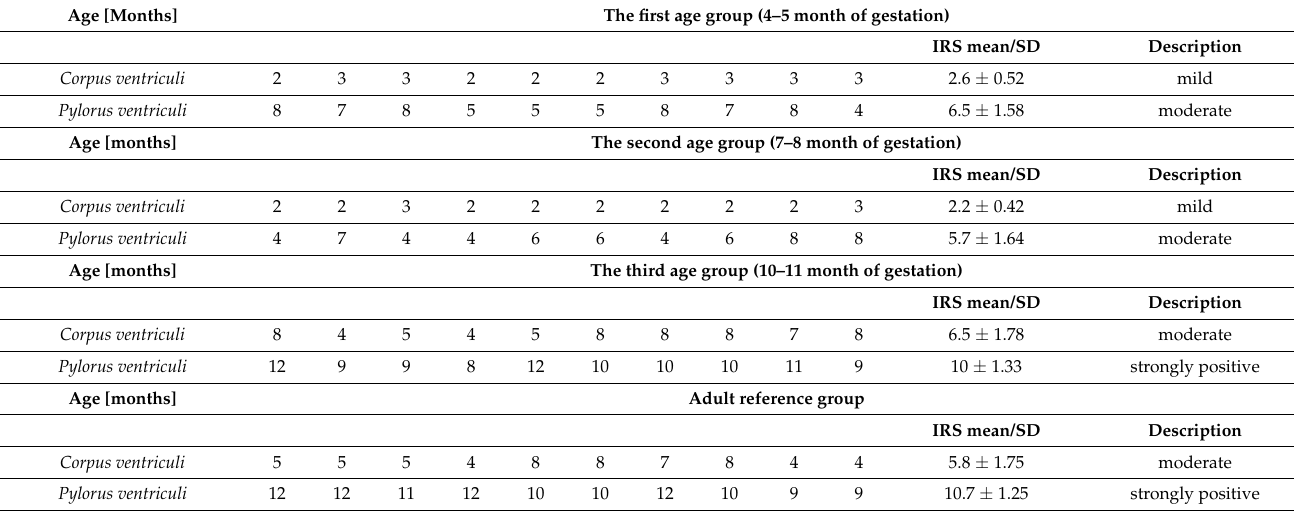
Table 6. Immunoreactivity of anti-somatostatin antibody.